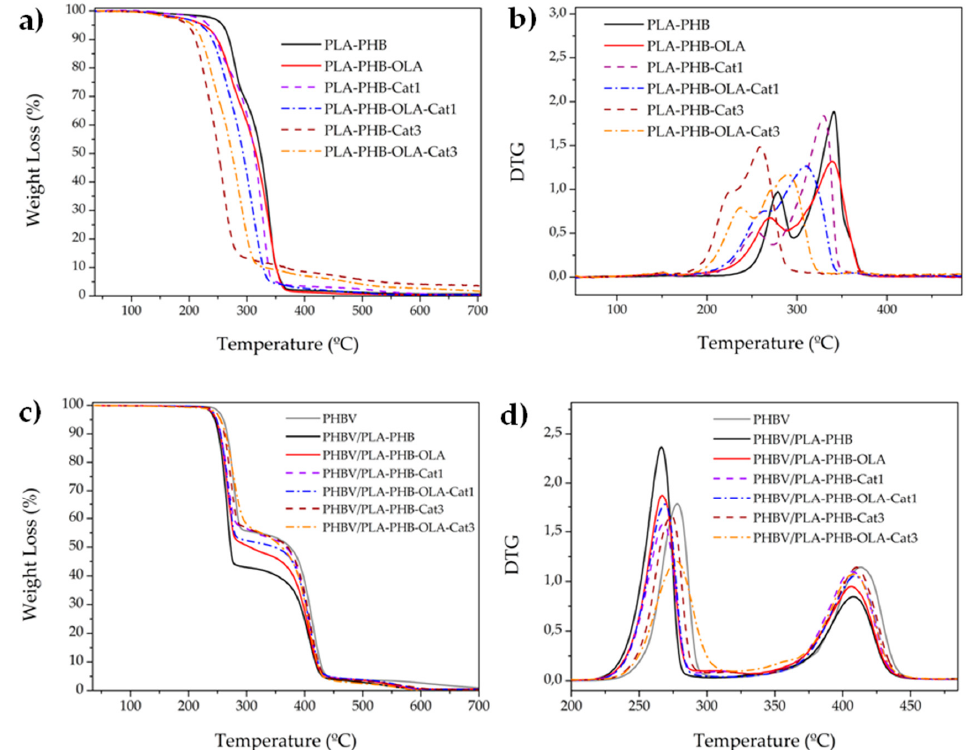
Figure 3. Dynamic TGA measurements of electrospun mats: ( a ) TGA and ( b ) DTG, as well as of bilayer systems: ( c ) TGA and ( d ) DTG. Table 2. TGA and DTG results of the electrospun fiber